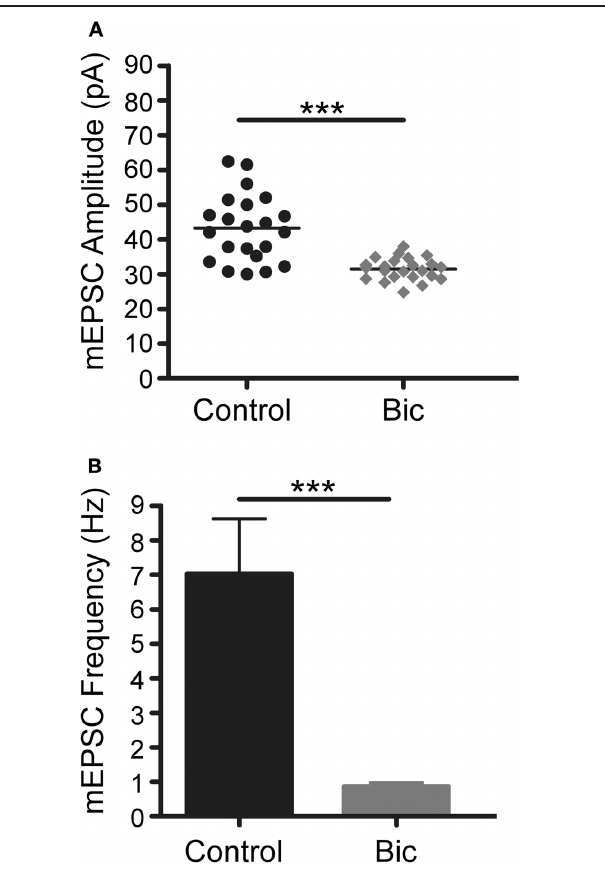
FIGURE 5 | Bicuculline treatment for 48h triggers homeostatic plasticity. (A) Vertical scatter plot showing the mean mEPSC size for a 5min recording session in untreated ( n = 22), bicuculline treated ( n = 23) neurons. (B) Average mEPSC frequency for the recordings shown in panel A . Between group statistical significance was determined using a One-Way ANOVA with Tukey’s multiple comparison test, ∗∗∗ p < 0 .